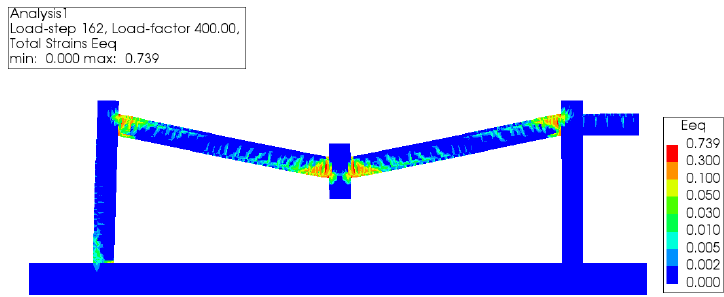
Figure 8. Numerical failure mode of single-storey frame.